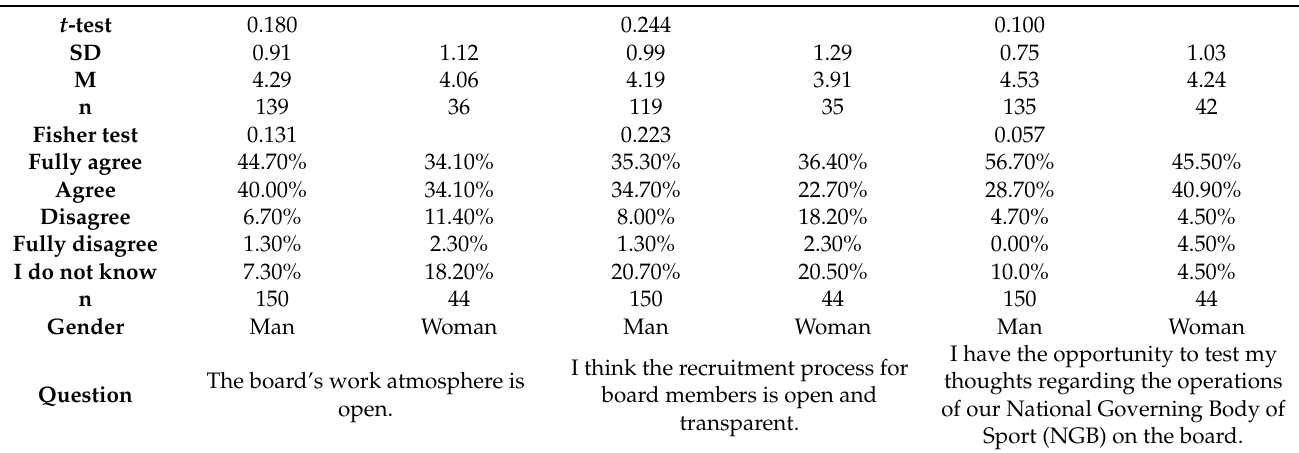
Table 1. Transparency and